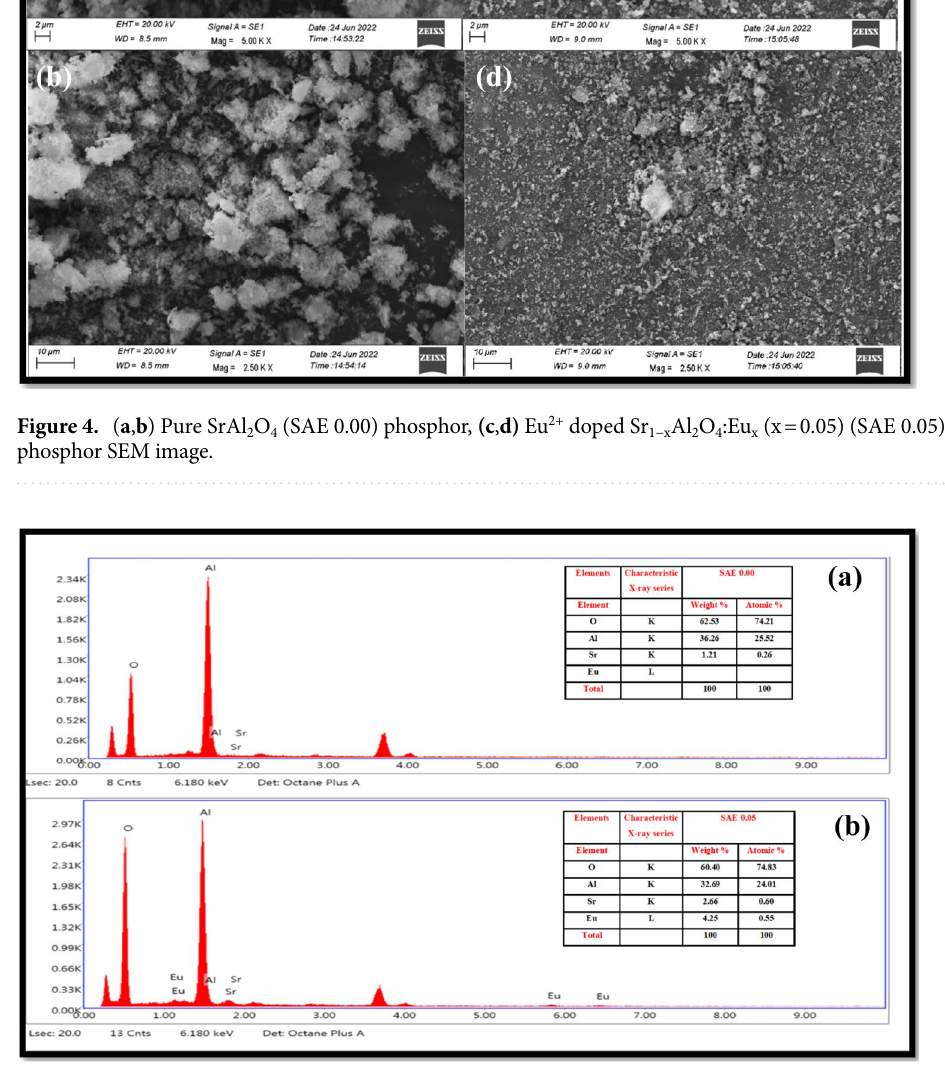
Figure 5. ( a ) Typical EDX spectra Sr 1−x Al 2 O 4 :Eu x (x = 0.00) (SAE 0.00) and ( b ) Sr 1−x Al 2 O 4 :Eu x (x = 0.05) phosphor (SAE 0.05)